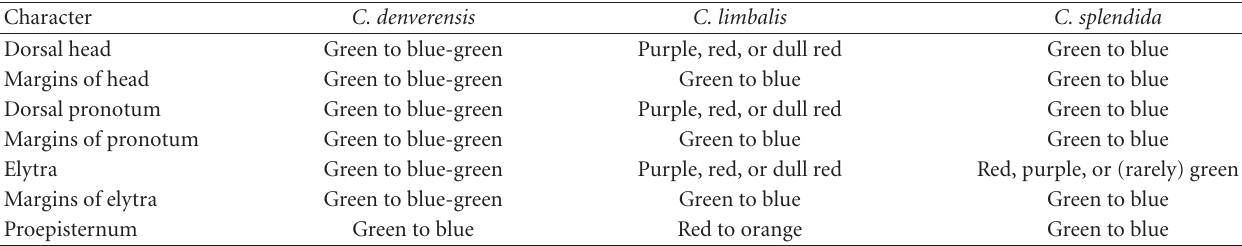
Table 1: Identification characters used to di ff erentiate between species in the Cicindela splendida group.